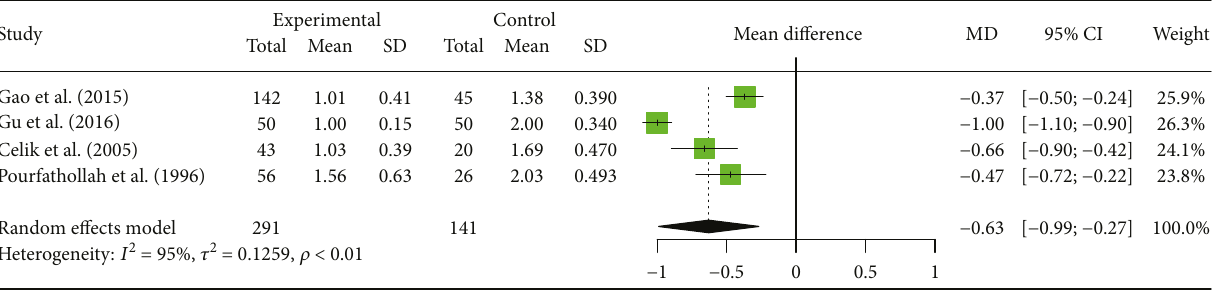
Figure 5: Forest plot of the changes of peripheral blood CD4+/CD8+ ratio in human brucellosis patients compared with controls.